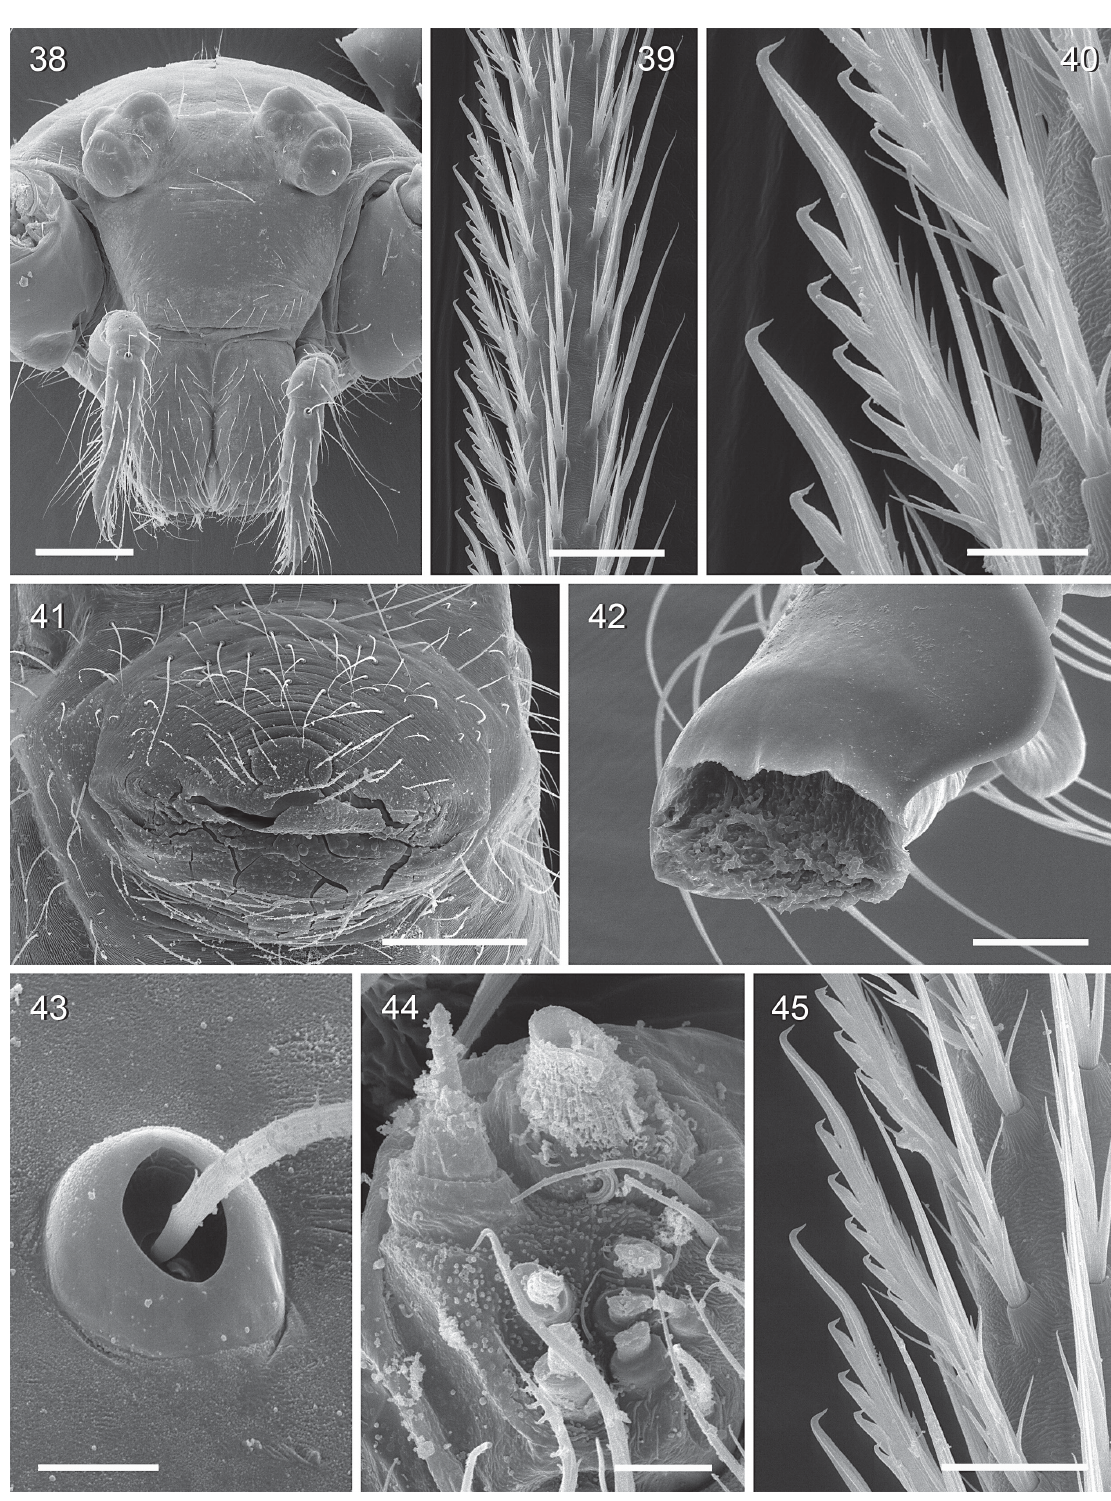
Figs 38–45. — 38–41. Panjange niah Huber, sp. nov. (ZFMK Ar 14580). 38 . Female prosoma, frontal view. 39–40 . Comb-hairs on female tarsus 4. 41 . Epigynum, ventral view. — 42–45 . Panjange kapit Huber, sp. nov. (ZFMK Ar 14583). 42 . Tip of left procursus, retrolatero-distal view. 43 . Base of palpal trichobothrium. 44 . Male ALS. 45 . Comb-hairs on male tarsus 4. Scale lines: 10 µm (40, 43–44); 20 µm (45); 40 µm (39); 60 µm (42); 200 µm (38,